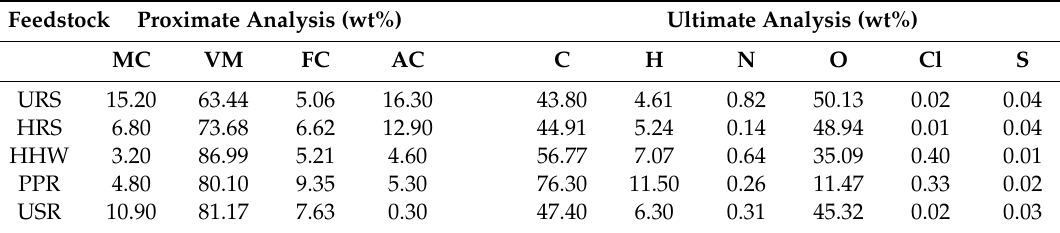
Table 1. Physicochemical characteristics of the feedstocks used in this study. Feedstock Proximate Analysis (wt%) Ultimate Analysis